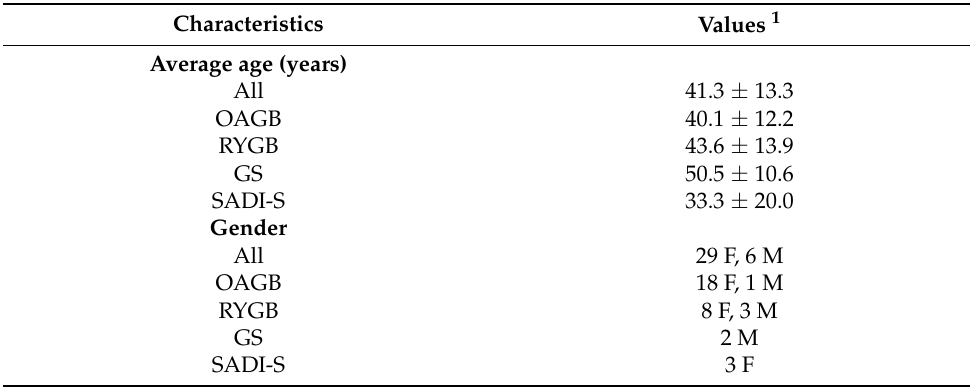
Table 1. Demographic data of the patients ( n =